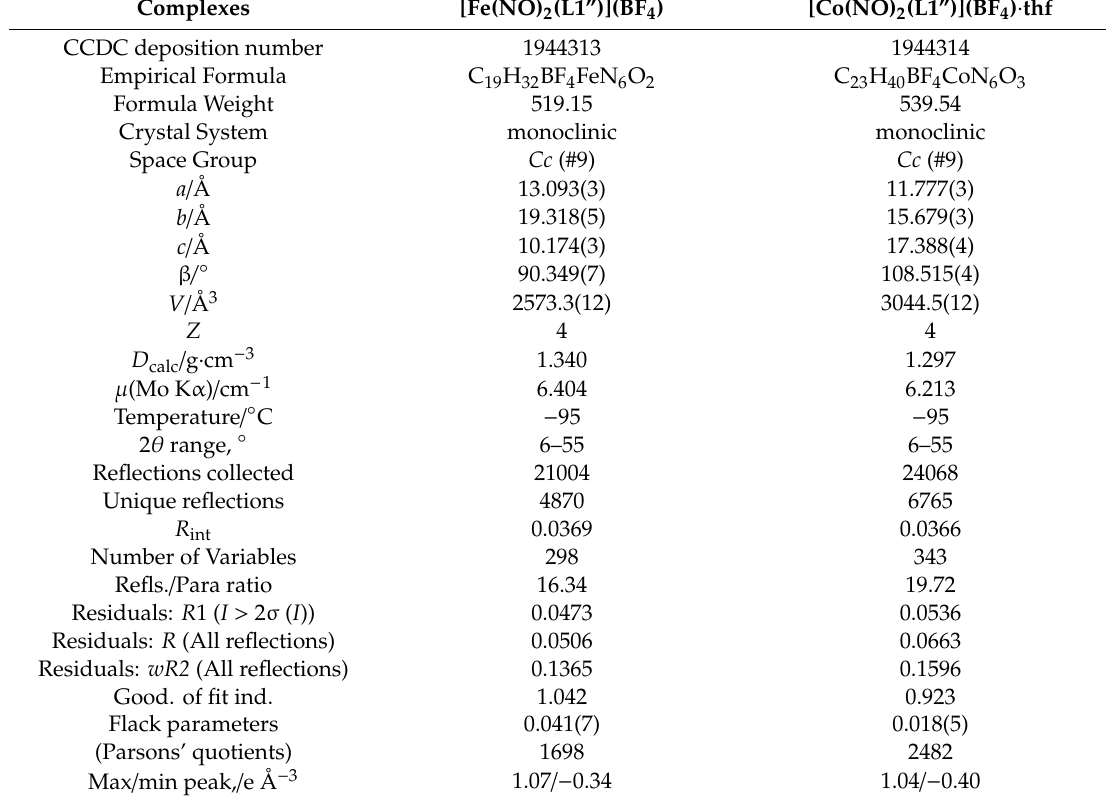
Table 3. Crystal data and structure refinement of dinitrosyl transition-metal